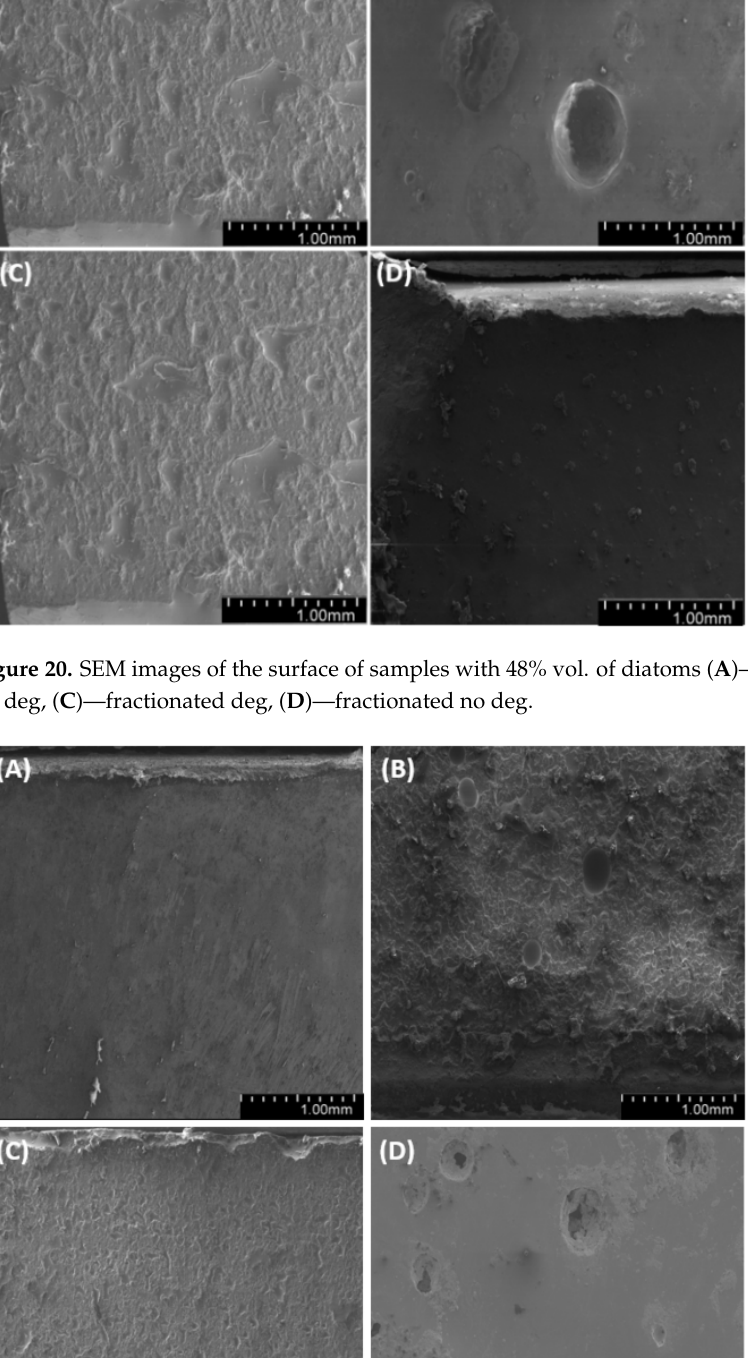
Figure 19. SEM images of the surface of samples with 36% vol. of diatoms ( A )—base deg, ( B )—base no deg, ( C )—fractionated deg, ( D )—fractionated no deg.